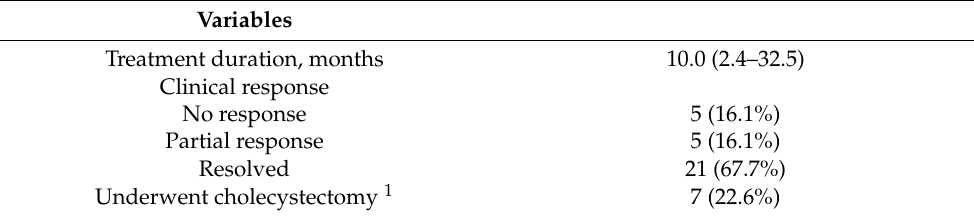
Table 2. Clinical outcomes ( n = 31).